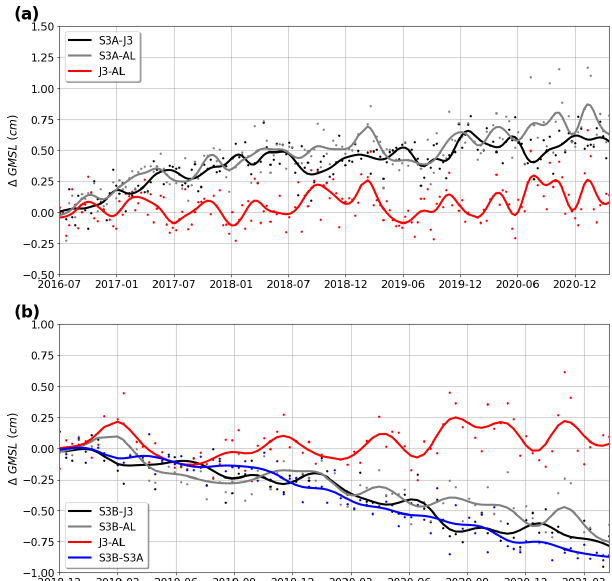
Figure 1. Evolution of (cid:49) GMSL (a) over the S3A period between S3A and Jason-3, S3A and SARAL/AltiKa, and Jason-3 and SAR- AL/AltiKa and (b) over the S3B period between S3B and S3A, S3B and Jason-3, S3B and SARAL/AltiKa, and Jason-3 and SAR- AL/AltiKa. The dotted curves are the raw time series sampled at 10d. The solid lines are time series filtered at 3 months with a low- pass filter. Each time series is artificially set to 0 at its